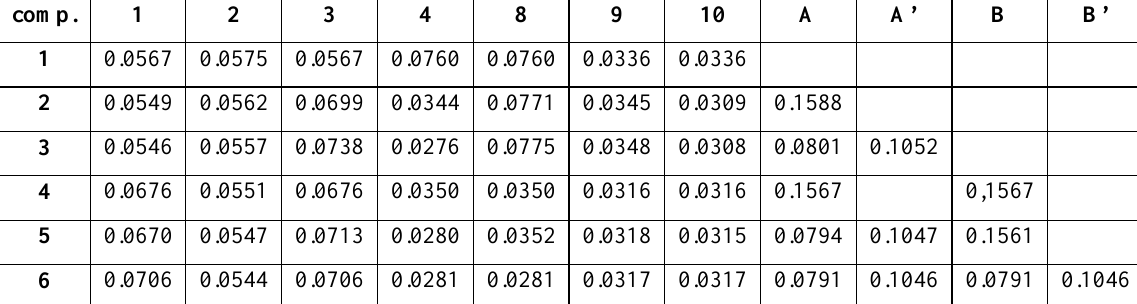
Table 1 – Energy effects (in β -units, β≈ -137 kJ mol - 1) of the rings of ovalene ( 1 ) and its annelated derivatives 2 - 6 , see Fig. 1. The labeling of the rings is also indicated in Fig. 1. The energy-effects of the rings 5, 6, and 7 are omitted because, by symmetry, these are always equal to the ef -values of the rings 3, 2, and 1, respectively.